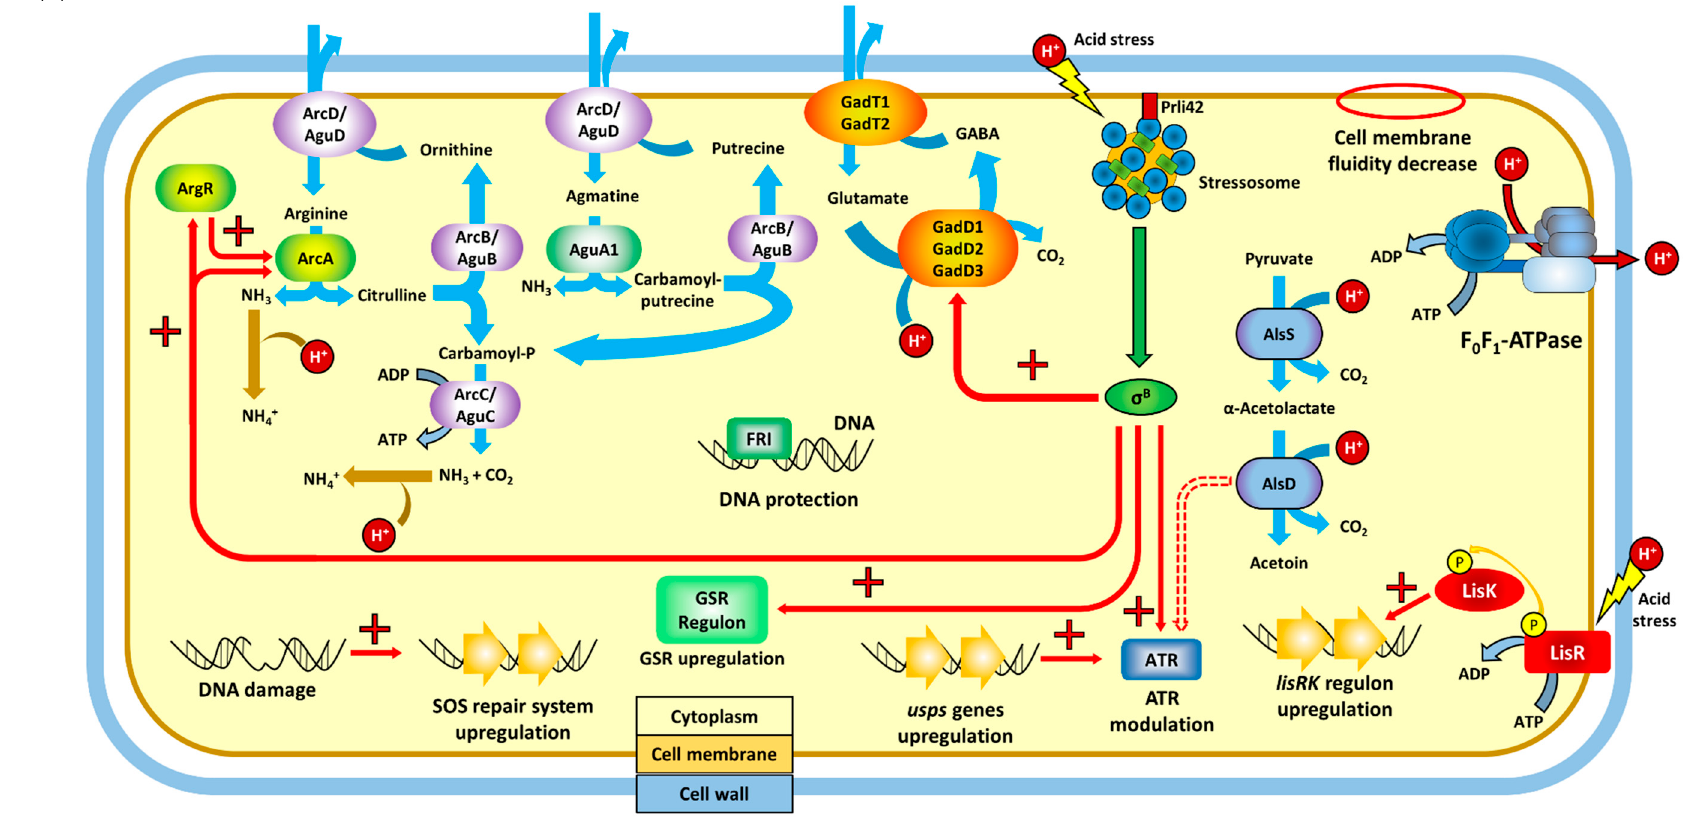
Figure 1. Schematic representation of the sensory, protective, and regulatory mechanisms triggered by environmental low pH conditions in E. coli ( A ) and L. monocytogenes ( B ). Red arrows represent upregulated ( + ) or downregulated ( − ) gene expression modulated by either periplasmic or cytoplasmic acidic pH. Decarboxylation and deamination reactions (represented by blue arrows) consume a proton (H + ) and produce CO 2 , or produce ammonia (NH 3 ), respectively. Ammonia can accept protons and yield ammonium (NH 4 + ), thus contributing to pH homeostasis. ( A ) EvgS is thought to act as the periplasmic acidic pH sensor in E. coli and is responsible for the initiation of a complex signal transduction pathway that activates GadE and ultimately results in the upregulation of acid tolerance mechanisms. ( B ) It is hypothesized that the stressosome acts as the cytoplasmic pH sensor in L. monocytogenes and is responsible for the initiation of a signal transduction pathway that results in the release of σ B and upregulation of the general stress response regulon (GSR).